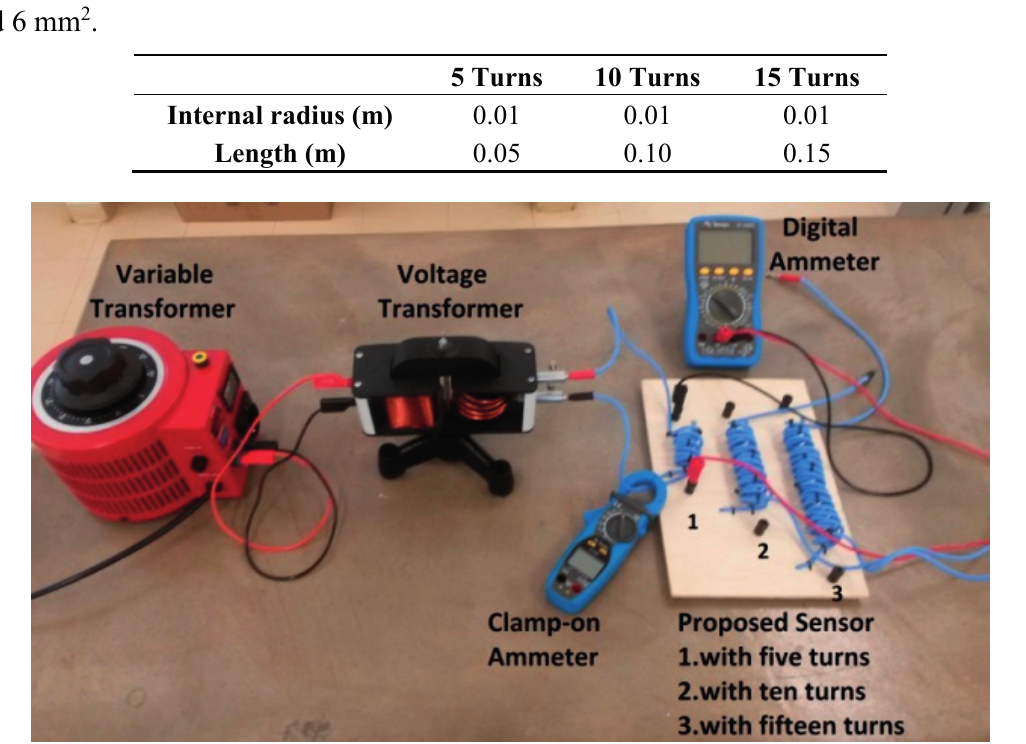
Figure 7. Test bench for the sensor